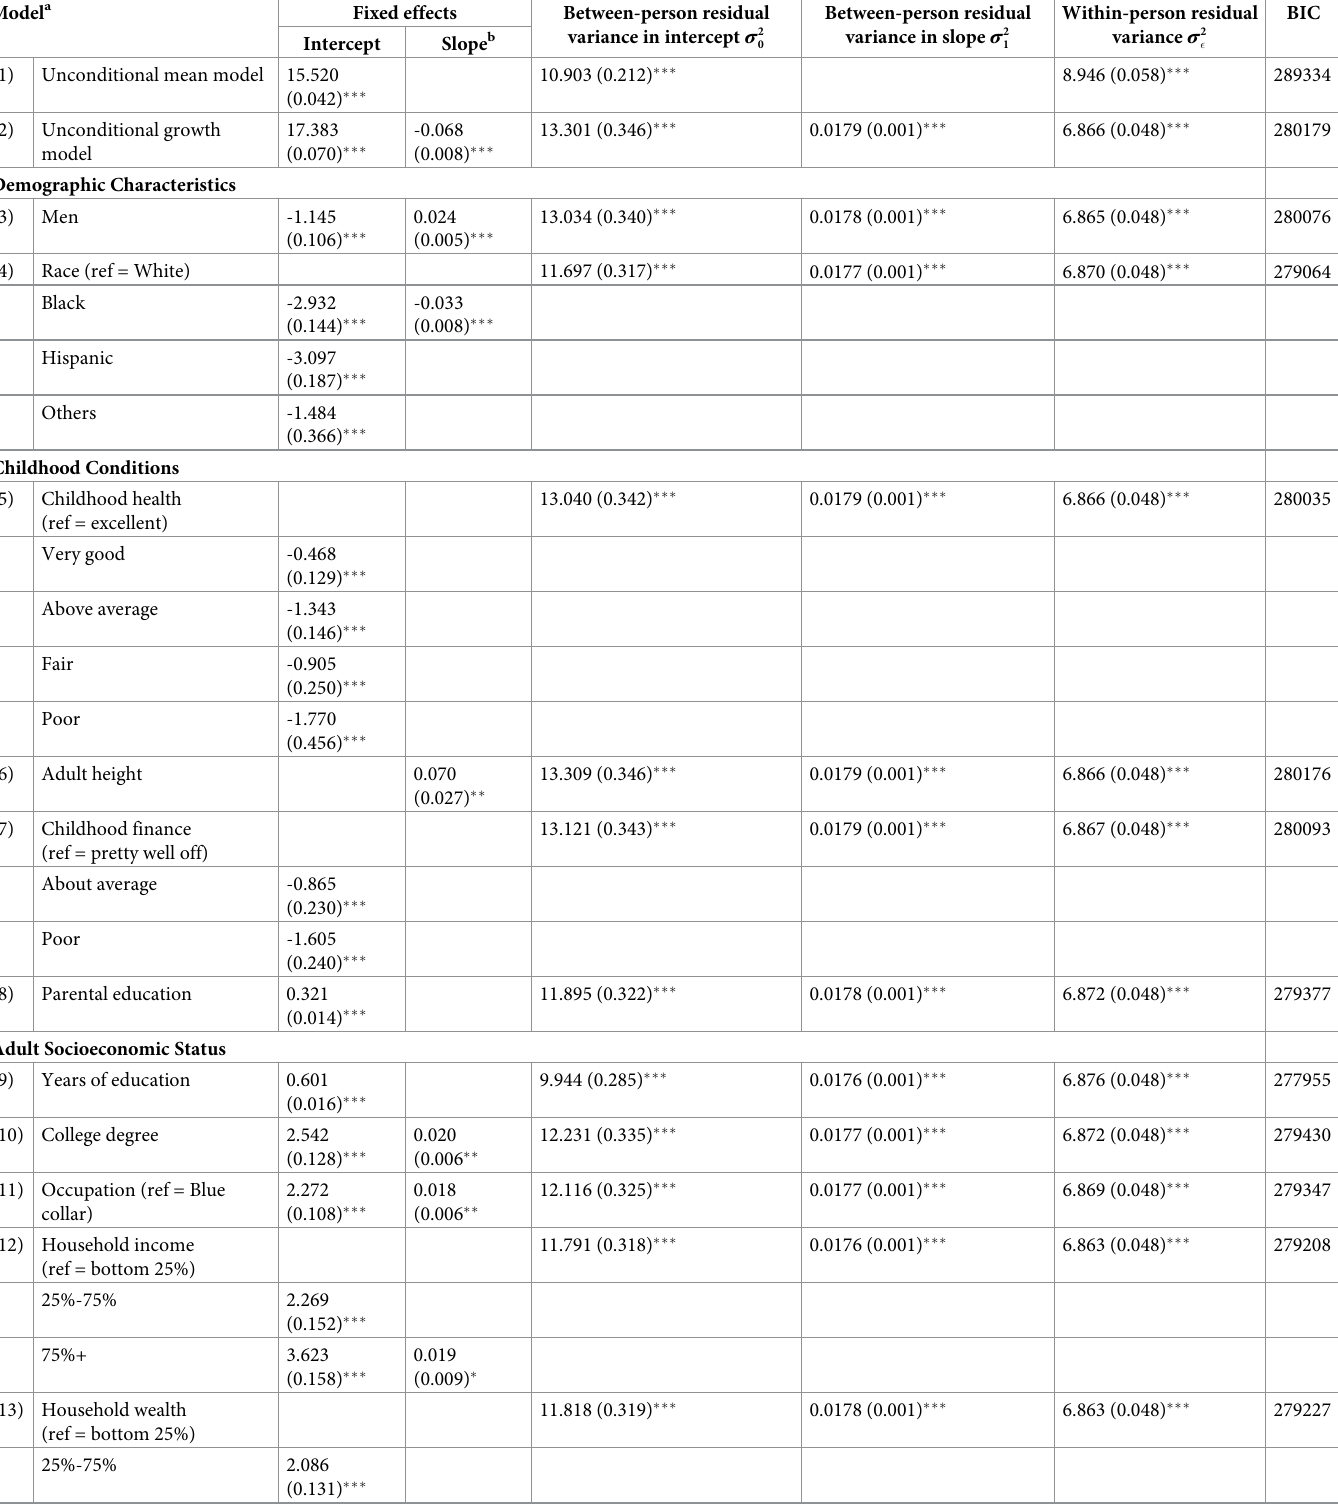
Table 2. Baseline predictors of intercepts and slopes of change of cognitive functioning from multilevel linear growth models, health retirement study,